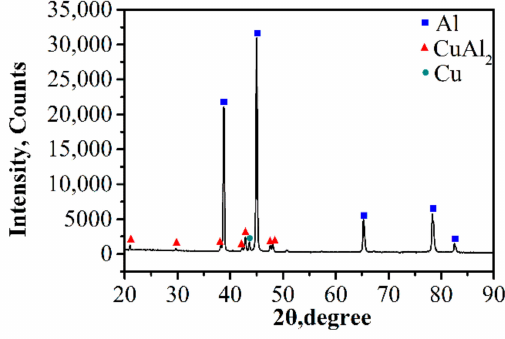
Figure 7. XRD patterns of the fracture